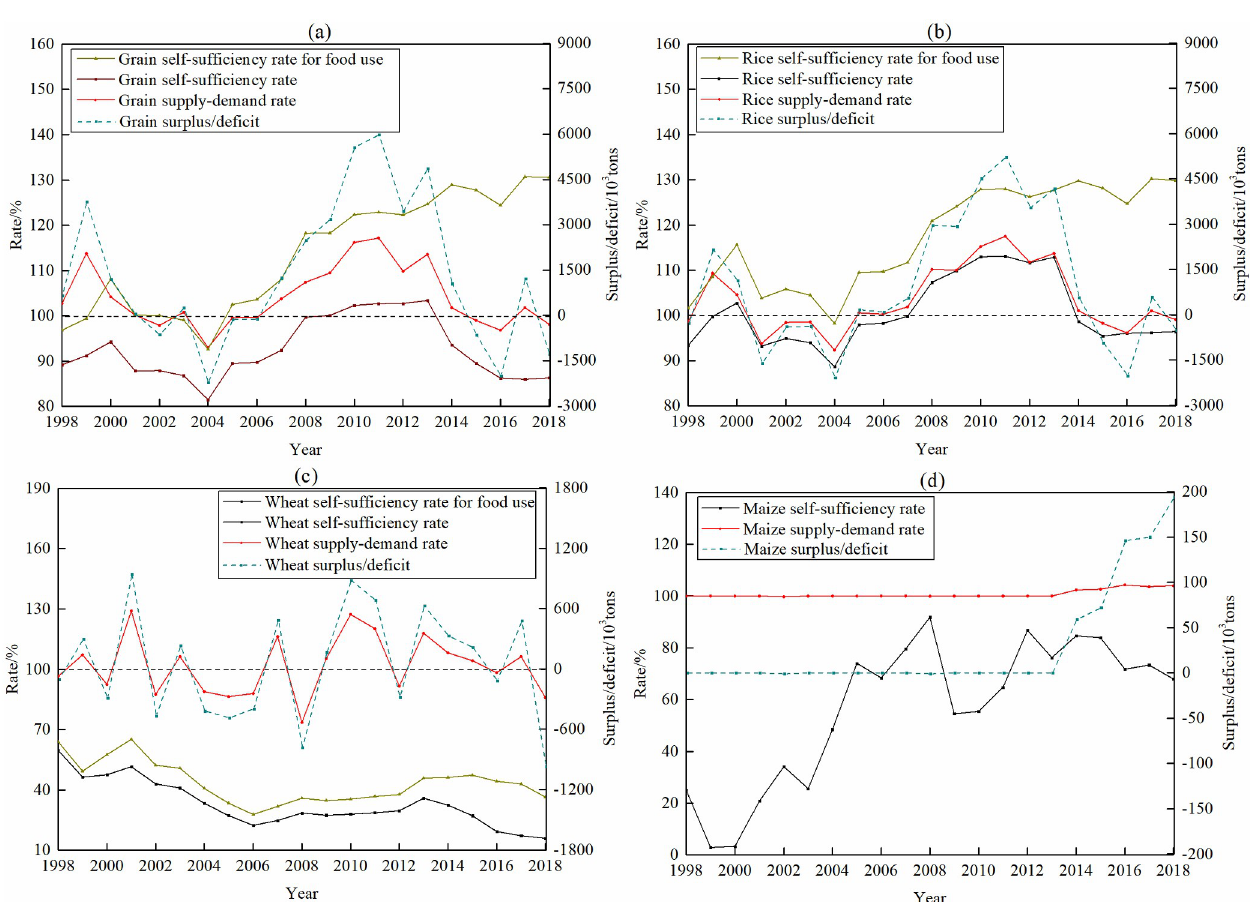
Fig 6. The supply and demand of grain products from 1998 to 2018 in Bangladesh. (a) Grain products, (b)Rice products, (c) Wheat products and (d) Maize products.